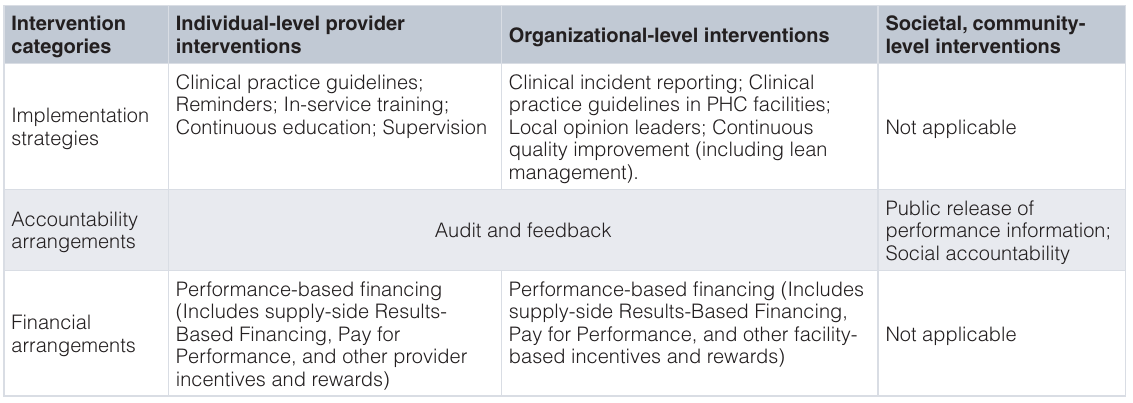
Table 1. Interventions of relevance to the evidence gap